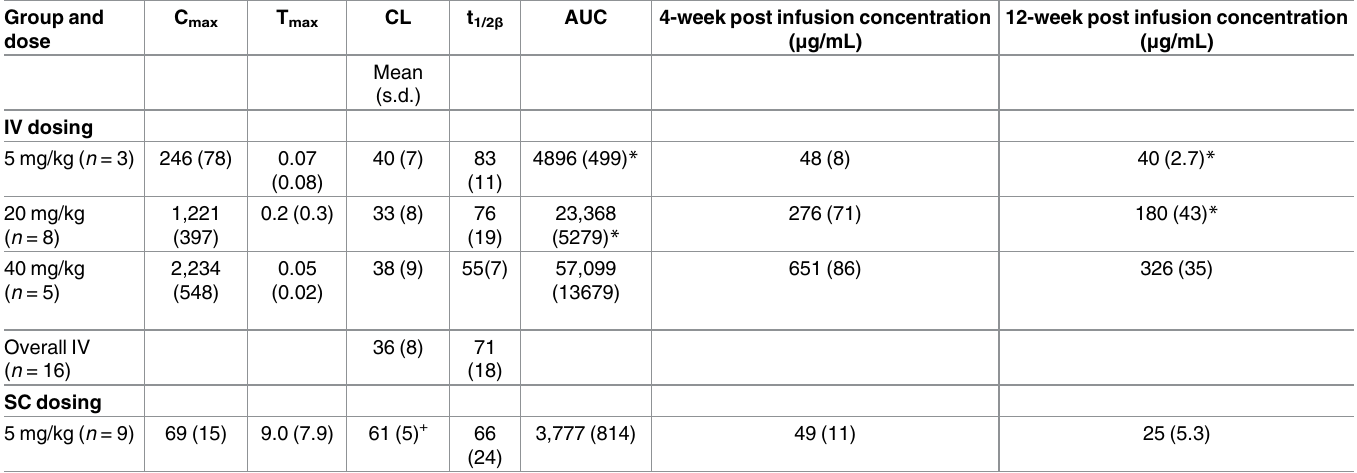
Table 4. VRC01LS mean PK parameter